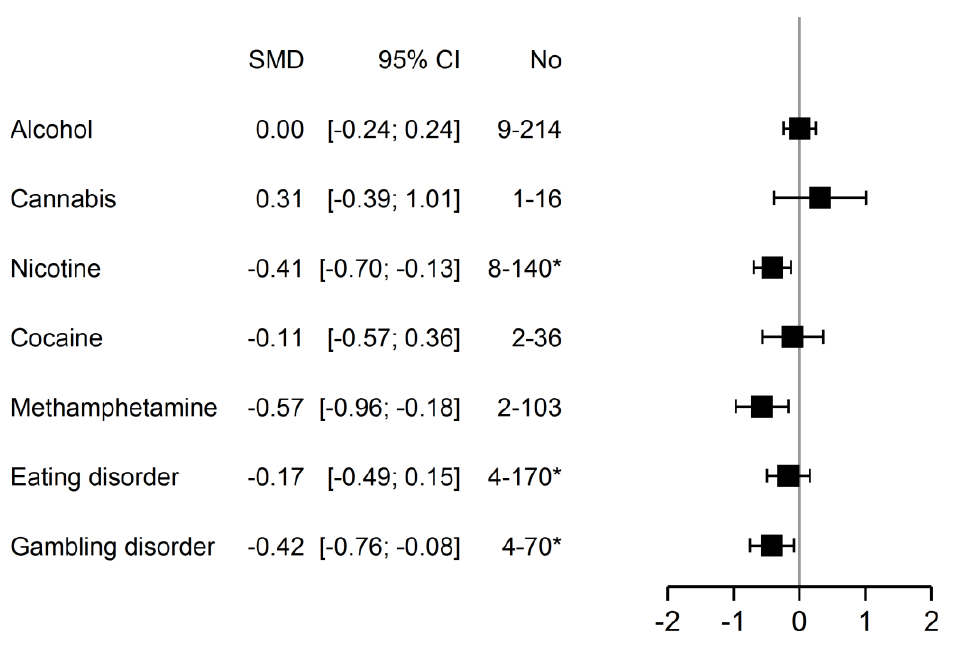
Figure 6. Subgroup analysis by addiction type using random effects model (without excluded studies, 30 units of analysis). (CI, confidence interval; No, number of units of analysis—number of patients included; SMD, standard mean difference). * Indicating difference between number of units of analysis and number of studies, with the following data: nicotine, 7–119; eating disorder, 3–133; gambling disorder, 3 – 61.